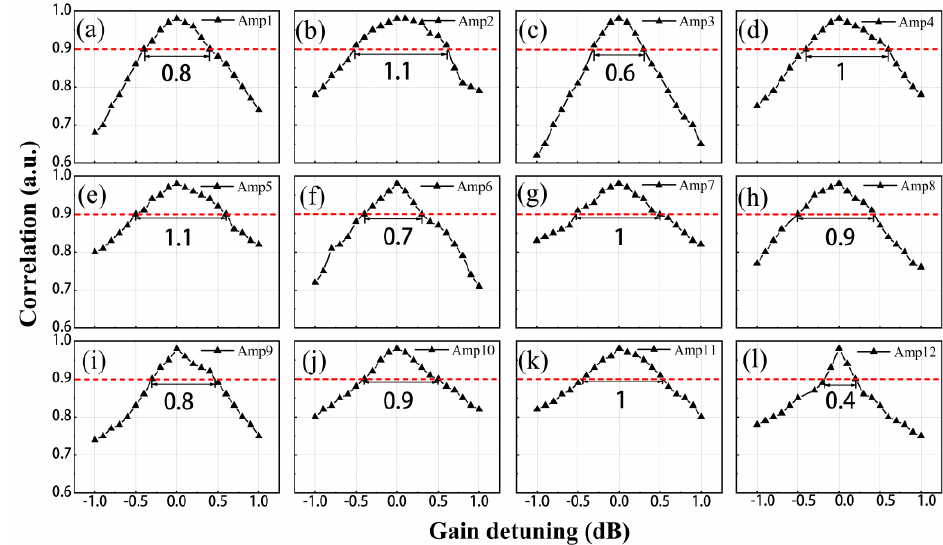
Figure 8. Effects of mismatch of amplifier gain on correlation coefficient. ( a – l ) The gain of amplifier is 20 dB.